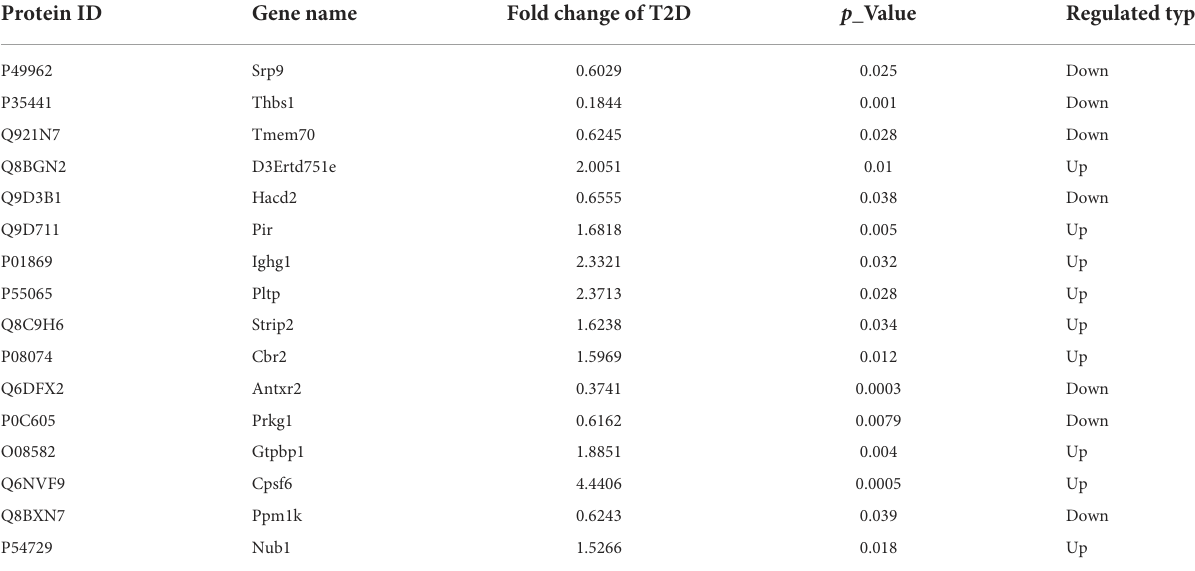
TABLE 1 Differentially expressed proteins between the T2D + SP group and T2D group. Protein